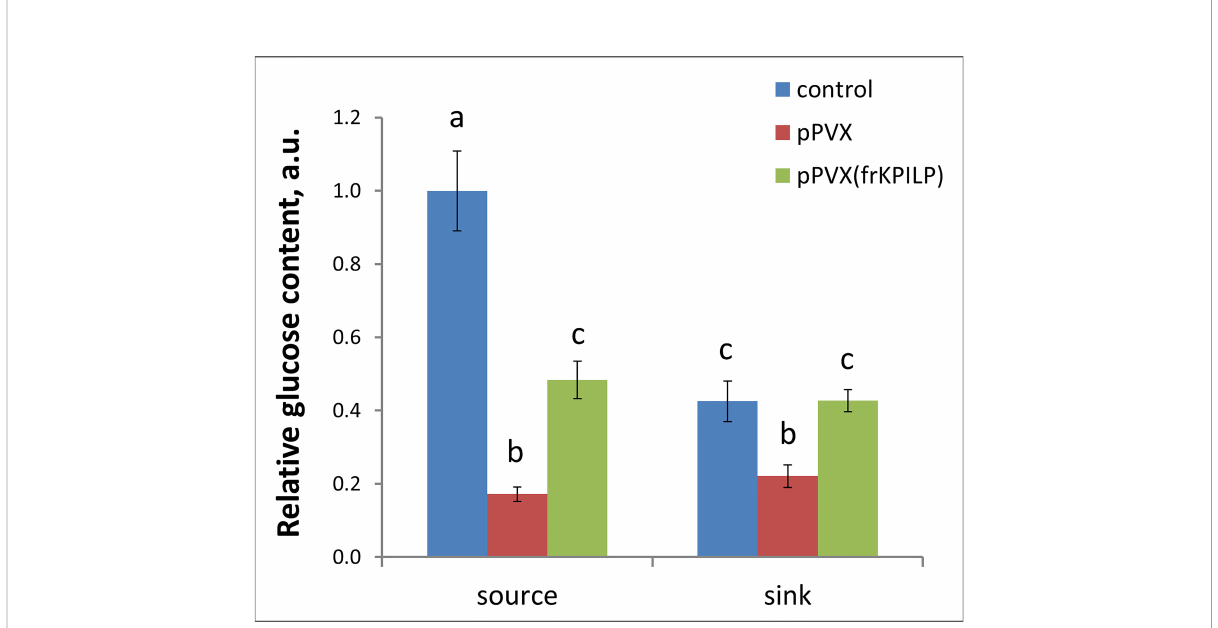
FIGURE 3 Relative glucose content in source leaves and sink tissues of N. benthamiana plants with pPVX or pPVX(frKPILP) systemic infection. The level of glucose in source leaves of control plants was taken as 1. Mean values and standard errors are presented. Bars without shared letters indicate signi fi cant differences at p<0.05 (ANOVA, Tukey ’ s